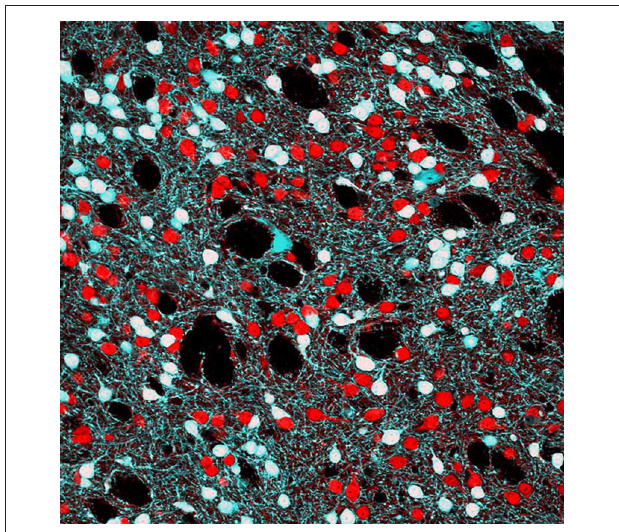
FIGURE 1 | Single confocal image showing DARPP-32 immunoreactivity (red) and EGFP fluorescence (cyan) in Drd2-EGFP BAC transgenic mice. DARPP-32 allows the identification of all striatal medium-sized spiny neurons (MSNs) while EGFP labels striatopallidal MSNs and large aspiny cholinergic interneurons. Picture by E.